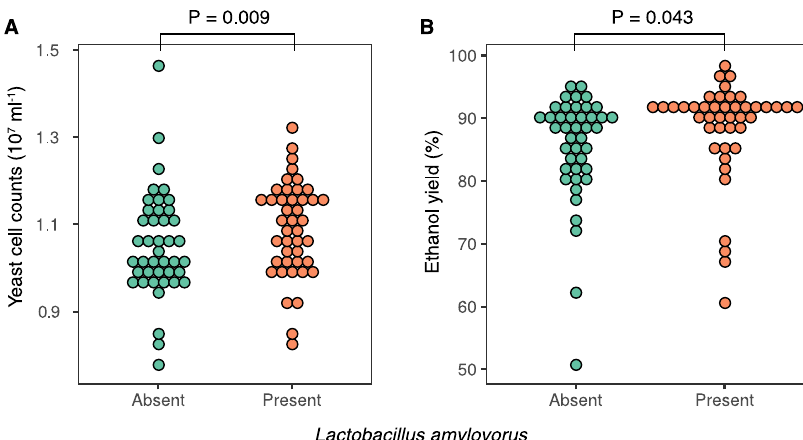
Fig. 4 The effect of the presence of L. amylovorus on ethanol fermentations. A Fermentations performed with L. amylovorus (beige circles) in the composition of the microbial community showed higher fermentation yields (3.02 ± 1.06%, p = 0.009; one-sided Wilcoxon rank-sum analysis) in comparison with the others lacking this species (green circles). B Fermentations with microbial communities containing L. amylovorus (beige circles) showed higher yeast cell counts (one-sided Wilcoxon rank-sum analysis, p = 0.043) in comparison with the others lacking this species (green circles). For all the results presented in this fi gure, n = 3 independent experiments. Source data are provided as a Source Data fi